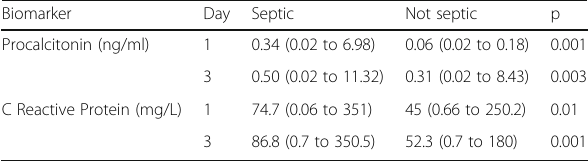
Table 3 (abstract 0364). Biomarkers on septic and non-septic